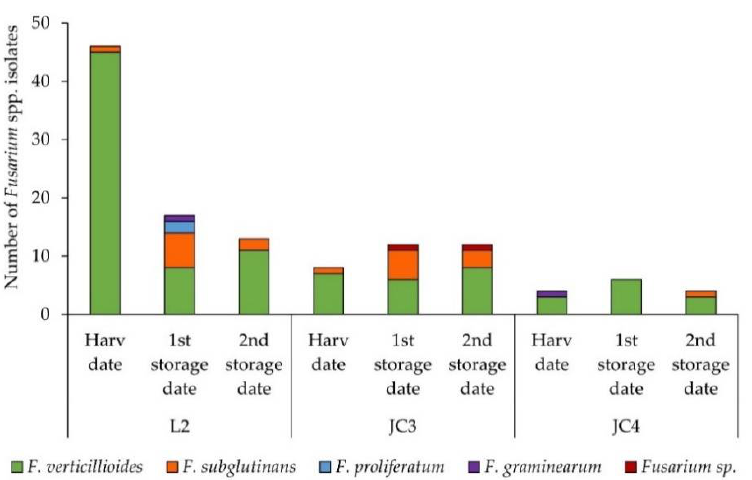
Figure 3. Distribution of Fusarium species per plot (L2, JC3, and JC4) and storage period, at harvest (Harv date), after 4 months of storage (1st storage date), and after 6 months of storage (2nd storage date) expressed as the number of contaminated grains per 50 grains analyzed.